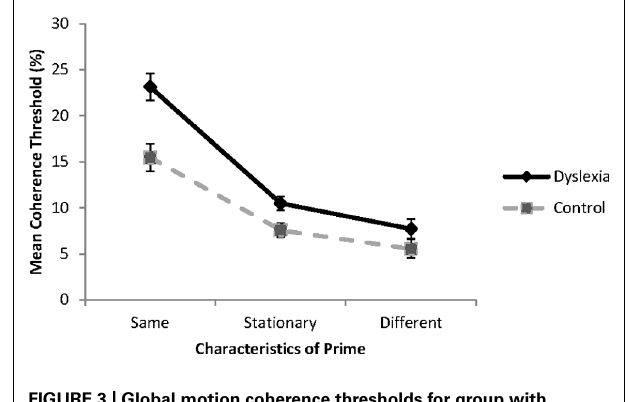
FIGURE 3 | Global motion coherence thresholds for group with dyslexia ( n = 10) and controls ( n = 10) when the probe and prime are presented in the same direction (same), in opposite directions (different) or when the prime is a stationary control stimulus. Standard error bars represent ± 1 standard